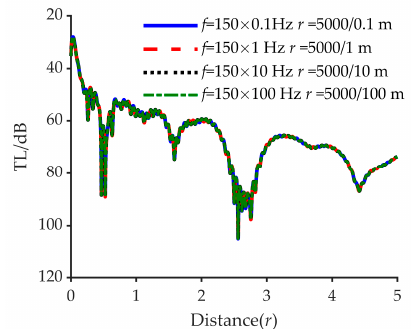
Figure 11. Transmission losses under the four scaling conditions. The solid blue line represents the frequency 150 × 0.1 Hz, the dashed red line represents the frequency 150 × 1 Hz, the dotted black line represents the frequency 150 × 10 Hz, and the dashed dotted green line represents the frequency 150 × 100Hz.